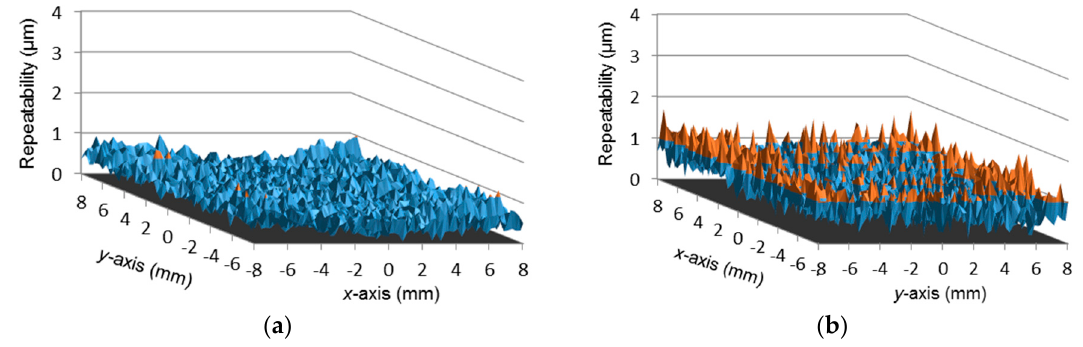
Figure 12. Measurement repeatability. ( a ) Repetitive error of the x -coordinate readings; ( b ) Repetitive error of the y -coordinate readings.